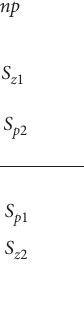
Figure 6: The poles and zeros are placed in the imaginary plane; o : zero, x : pole.